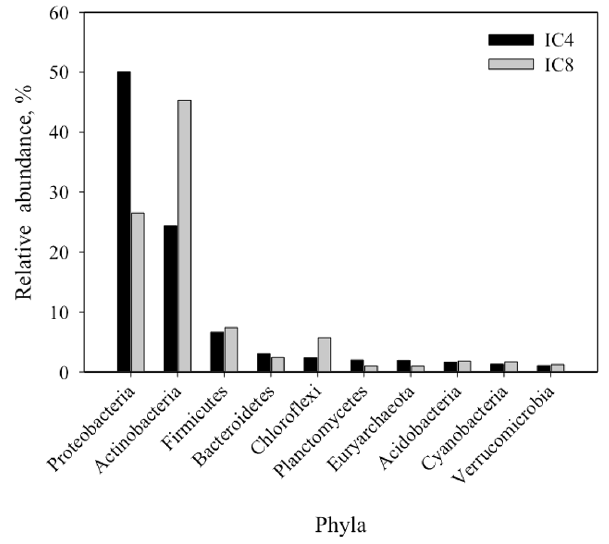
Figure 2. Community analyses of the IC4 and IC8 metagenomes at phylum level. The phyla present in metagenomes at a >1% level are